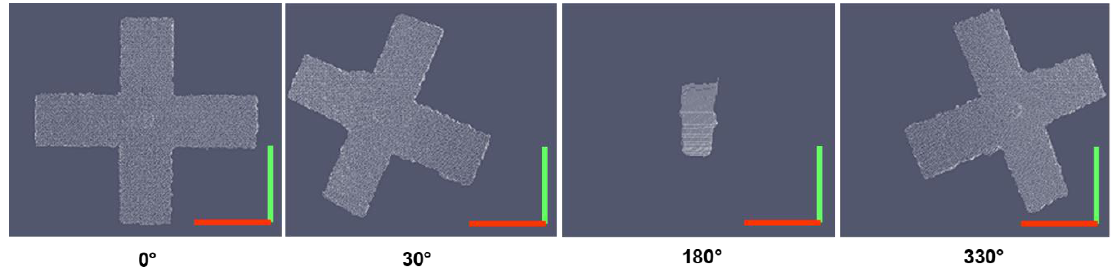
Figure 5. Extracted point clouds at the four angular positions of the camera, during the calibration step B. The red axis corresponds to the x camera axis and the green axis corresponds to the y camera axis.